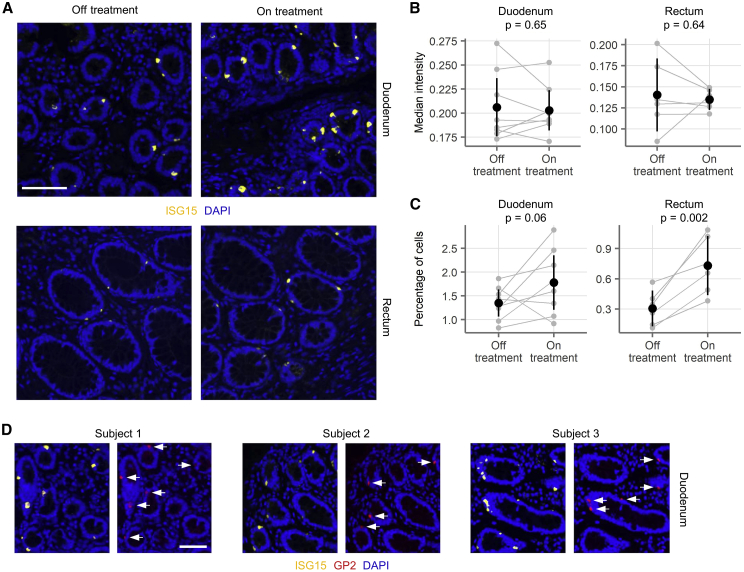
Immunofluorescence Microscopy Staining for ISG15(A) 20× magnification images of duodenal (top) and rectal (bottom) biopsies, stained for ISG15 (yellow) and DAPI (blue). Biopsies from pre-treatment (left) and at the end of 2 months of treatment (right) are shown. Scale bar, 100 μm. The duodenal biopsies came from one donor and the rectal biopsies came from a second donor.(B) ISG15 intensity on ISG15+ cells was measured in paired duodenal (n = 8 donors) and rectal (n = 6) biopsies from ACTU-3500. The median intensity of all of the cells measured is shown.(C) The percentage of ISG15+ cells out of all epithelial cells is shown for the same biopsies as in (B). In (B) and (C), gray points indicate measurements from a single biopsy, with gray lines connecting the matching observation from the same donor. The black symbols and vertical lines show the means and 95% confidence intervals of the mean. p values are indicated from one-sided paired t tests.(D) Co-staining of duodenal biopsies from three individuals for ISG15 and glycoprotein 2 (GP2). Anti-GP2 was raised against a peptide component of pancreatic secretory (zymogen) granules and has some cross-reactivity with microfold (M) cells. GP2+ cells co-express ISG15 (white arrows), but not all ISG15+ cells are GP2+. Scale bar, 100 μm.